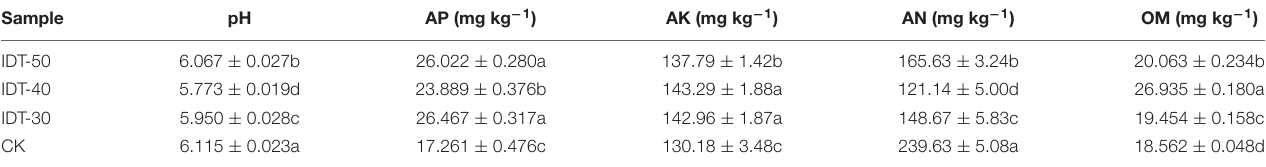
TABLE 2 | Plant rhizosphere soil physicochemical analysis among